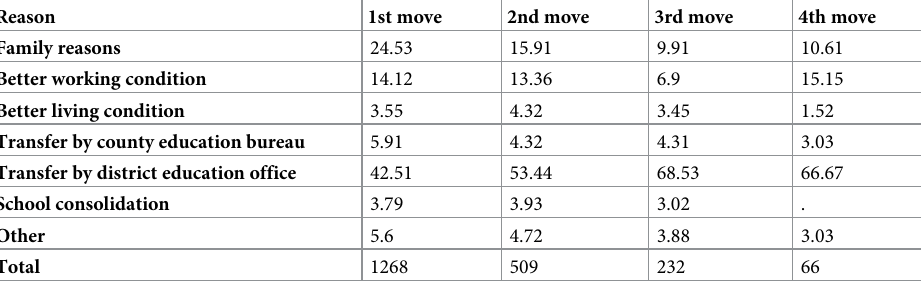
Table 2. Reasons for moving to other schools in the 1st, 2nd, 3rd, and 4th moves (%). Reason 1st move 2nd move 3rd move